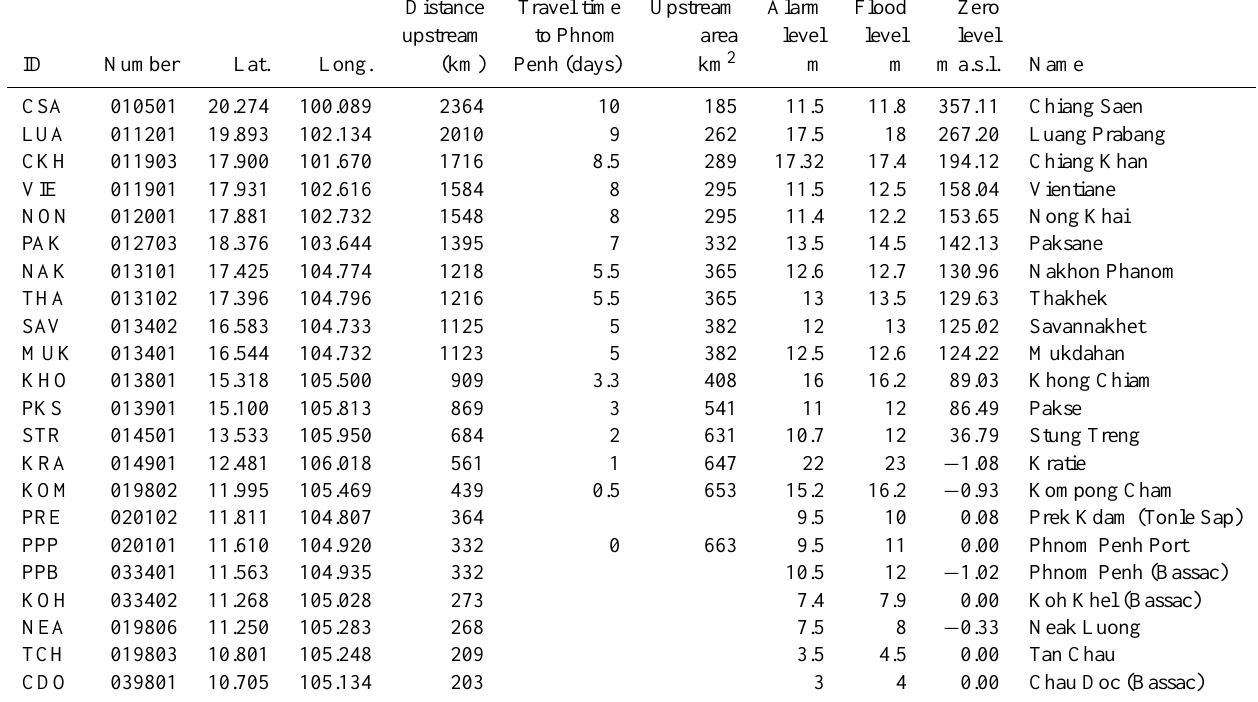
Table 1. Characteristics of forecast points along the Mekong River. ID is the identifier in the RFMMC forecasting system and number is the identifier of the station in the MRC’s Master Catalogue. Zero level is the datum of the river gauge. Anglicized names may vary by source (e.g., Pakse versus Pakxe or Paksé). Contributing area for locations below Phnom Penh vary seasonally due to the reversal of